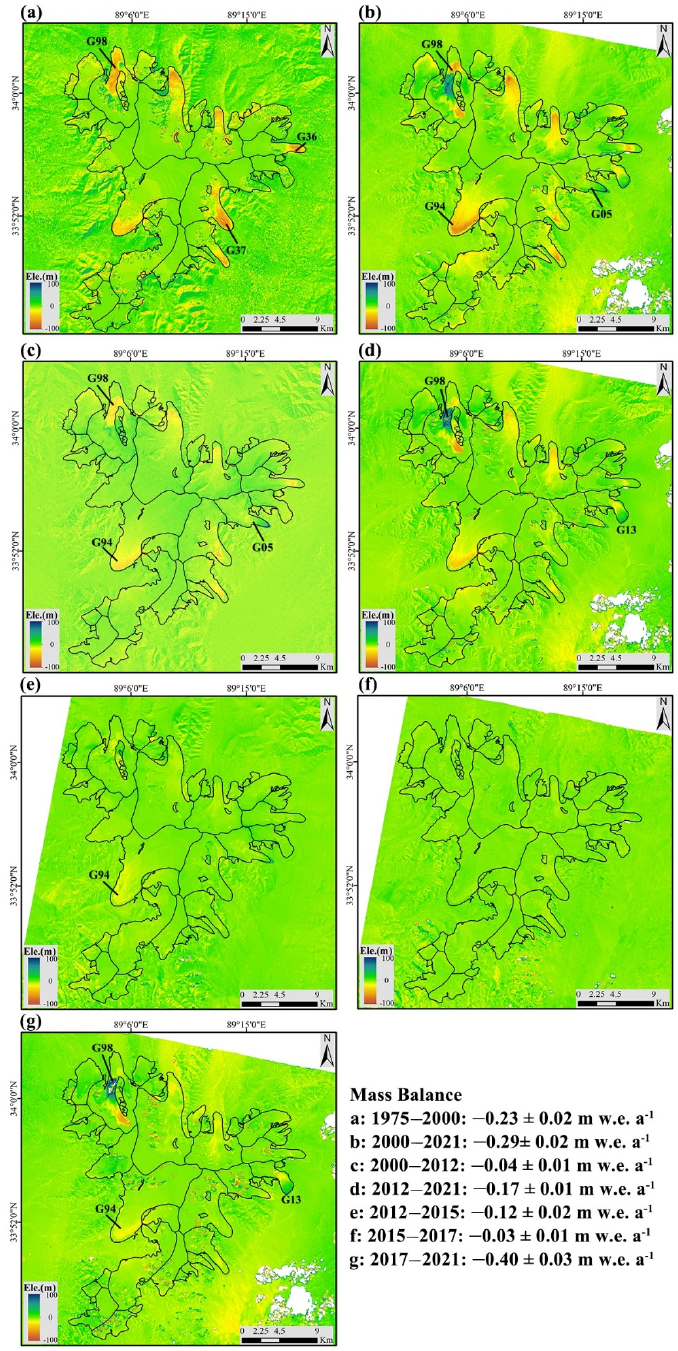
Figure 8. Maps of the glacier surface elevation changes: ( a ) 1975–2000; ( b ) 2000–2021; ( c ) 2000–2012; ( d ) 2012–2021; ( e ) 2012–2015; ( f ) 2015–2017; ( g ) 2017–2021; the mass balance values are presented in the last panel (bottom right).